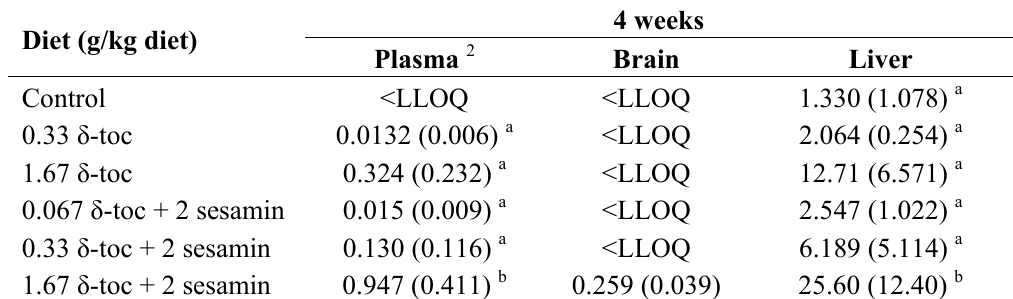
Table 2. Concentration (µM) of δ -toc in plasma, brain, and liver of Balb/cJ mice following 4 weeks dietary supplementation with δ -toc or δ -toc plus sesamin 1